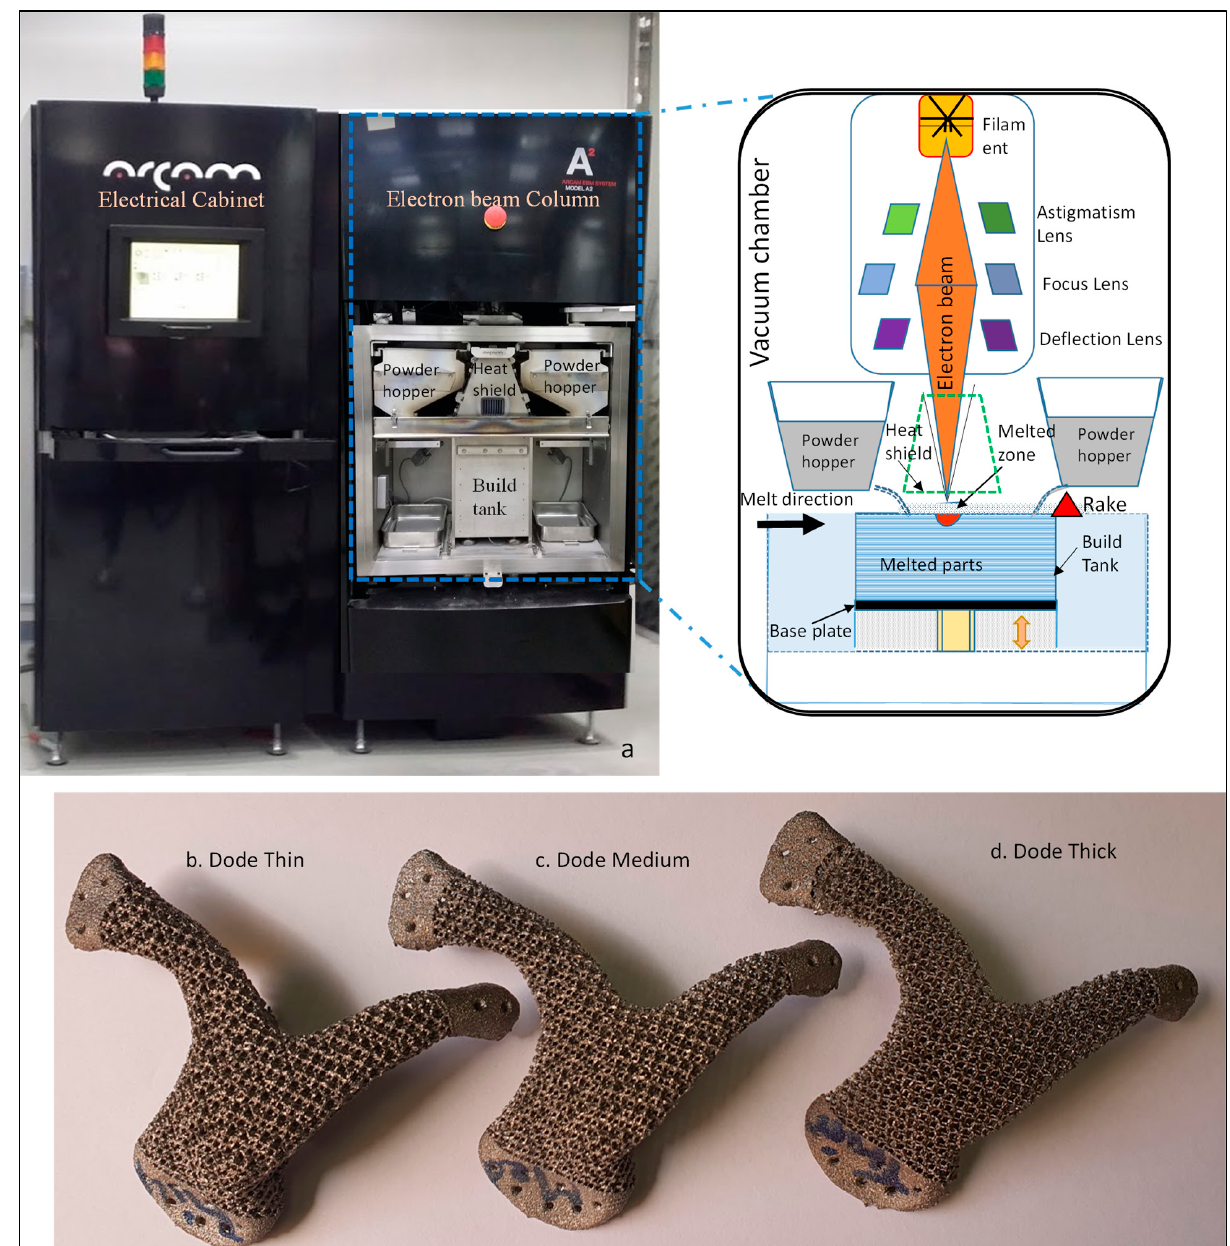
Figure 6. ( a ) Schematic diagram of the EBAM work cycle, and the fabricated scaffolds of ( b ) dode thin, ( c ) dode medium and ( d ) dode thick.